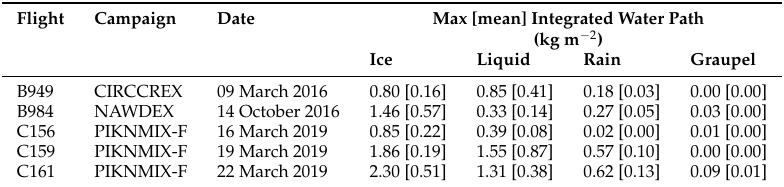
Table 2. FAAM BAe-146 flights used for this study, and integrated water path statistics from the NWP